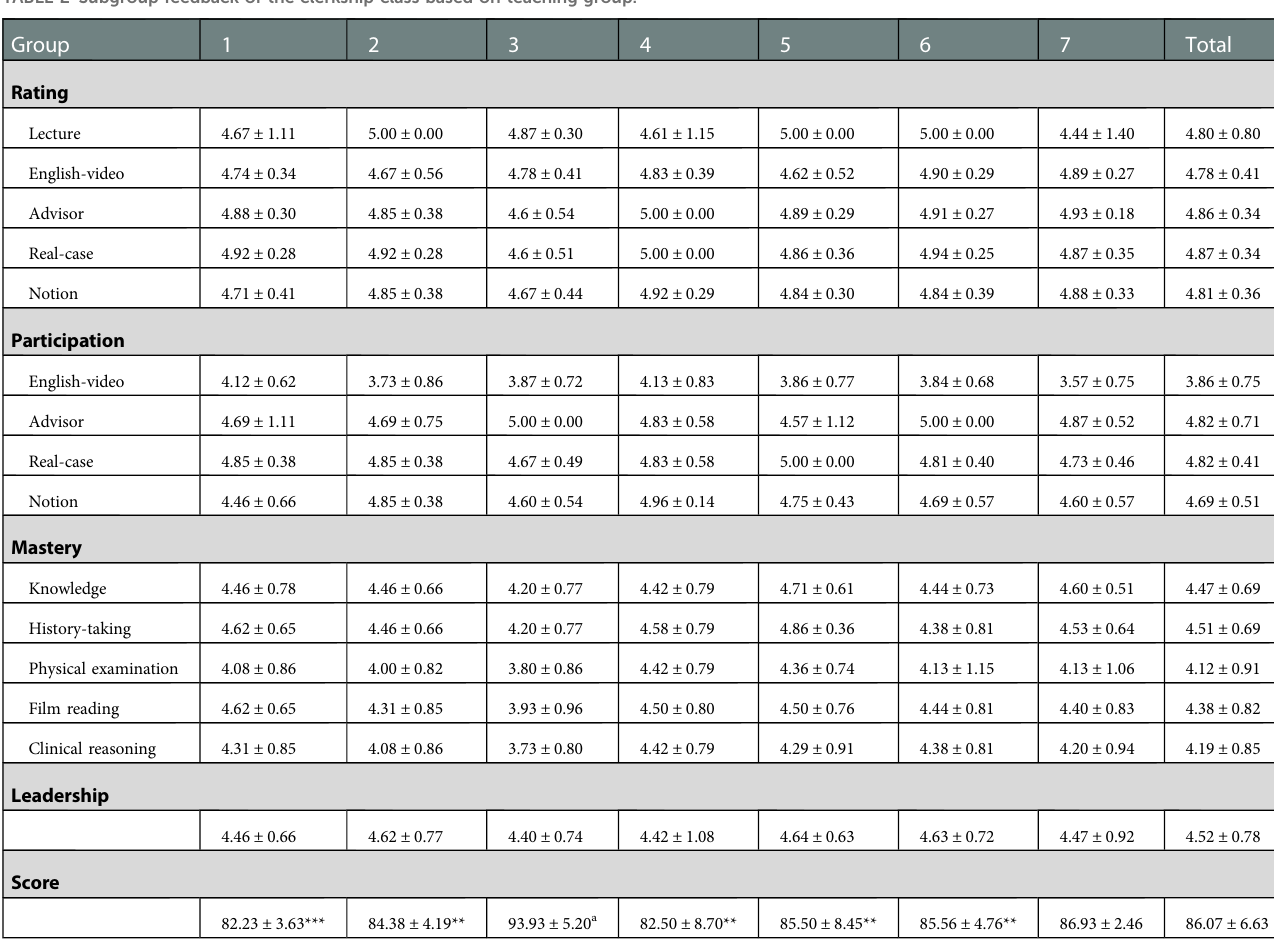
TABLE 2 Subgroup feedback of the clerkship class based on teaching